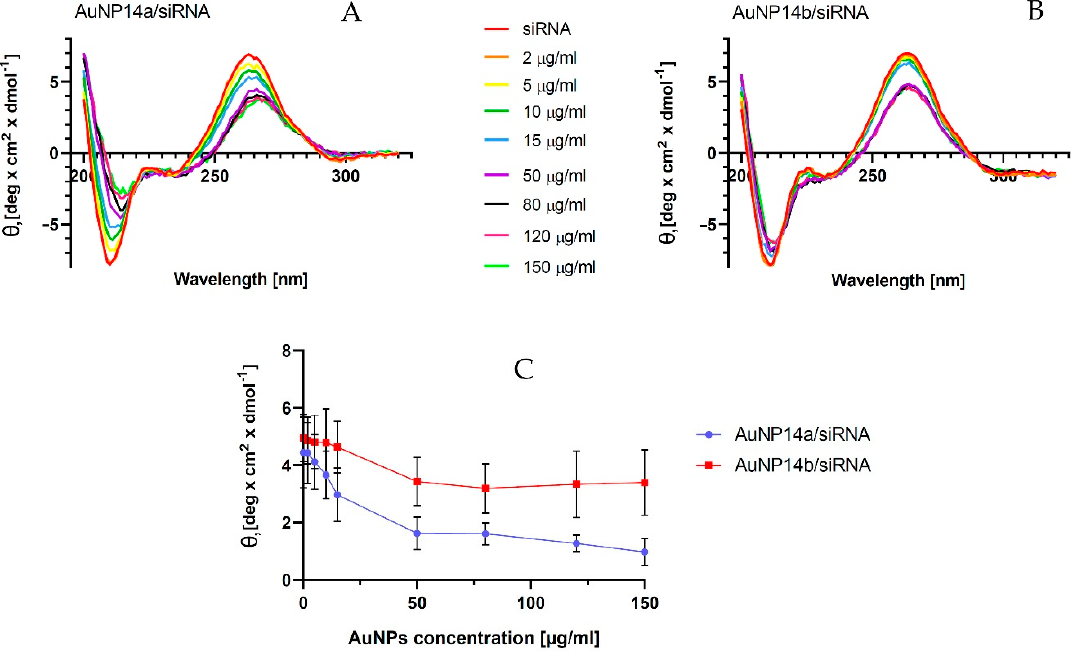
Figure 4. Effect of gold nanoparticles on siRNA’s secondary structure ( θ —ellipticity). ( A ) Spectra CD of siRNA at the presence of AuNP14a, and ( B ) AuNP14b. ( C ) Changes in mean ellipticity at λ = 265 nm. Measurements were conducted in λ = 200–320 nm in phosphate buffer, pH = 7.4. The concentration of siRNA 1 µmol/L. The values are the mean ± standard error of the mean (SEM), n = 3.